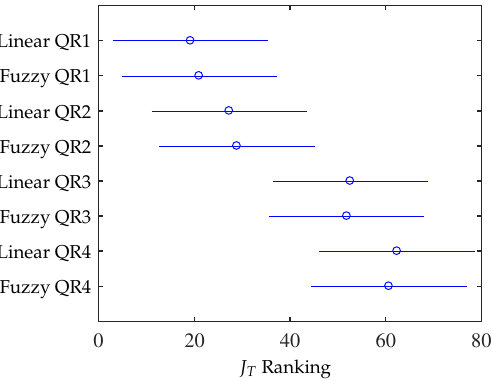
Figure 19. Multiple comparison using Bonferroni procedure.